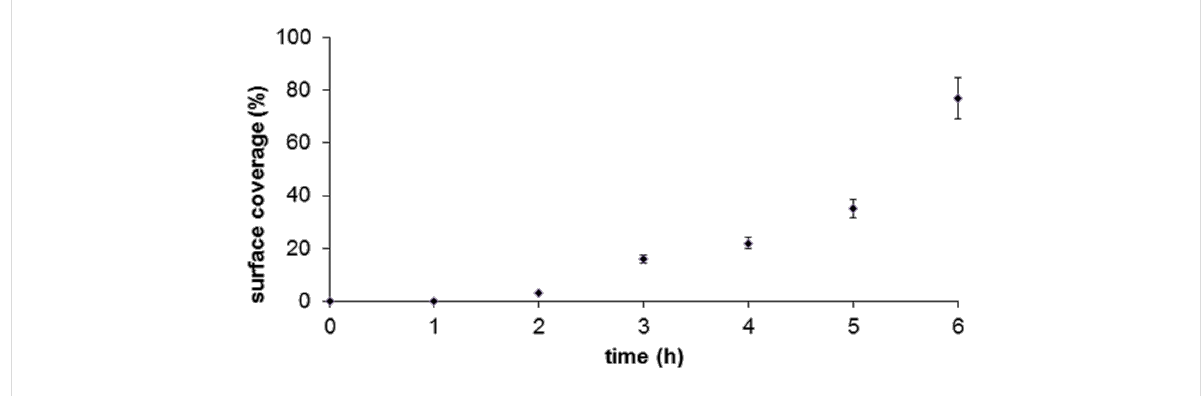
Figure 3: Gradual increase in surface coverage of the taller (standing) phase of TMMH as time progressed.